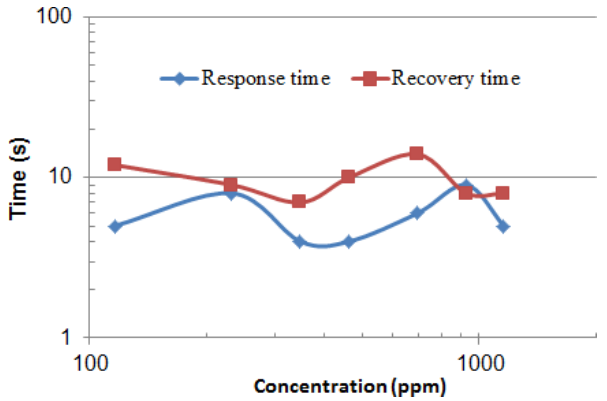
Figure 12. Dependence of response and recovery times of MWCNTs/SnO 2 FA vapor sensor on gas concentration measured at 200 ◦ C operating temperature.